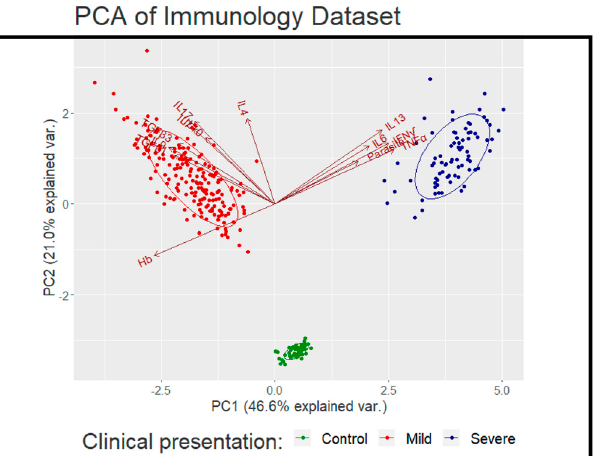
Figure 4. Dimensional analysis indicated the strongest contribution of TNF- α , IFN- γ , and IL-13 to- wards disease severity, while parasitaemia had the weakest contribution. On the other hand, TGF- β 1, TGF- β 3, and IL-9 had the strongest contribution towards mild cases. The levels of IL-4 were not significantly different between mild and severe cases.